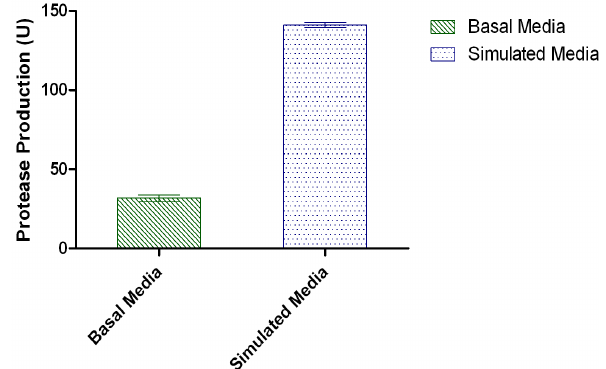
Fig. 3. Effect of different sulphate sources on alkaline protease production